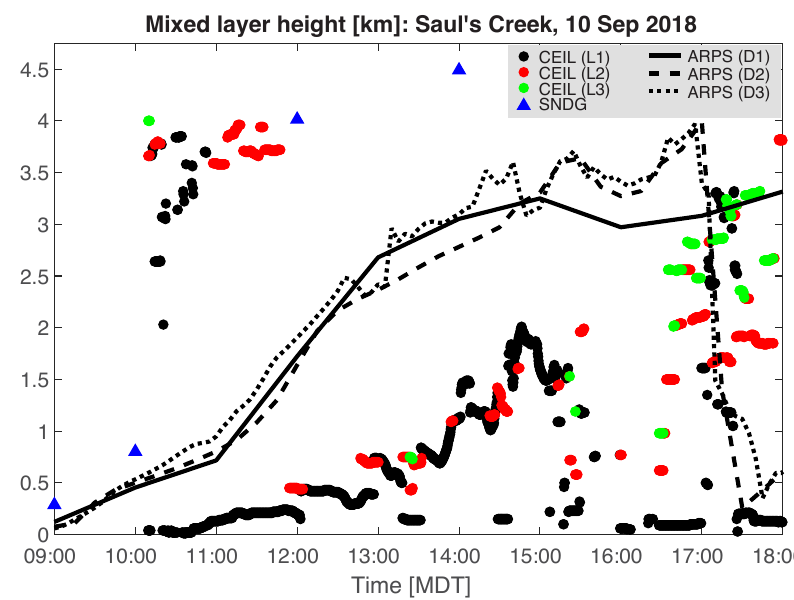
Figure 4. Time series comparison of observed mixed layer height from ceilometer aerosol backscatter returns (CEIL (three aerosol layers): black, red, and green circles) and portable rawinsonde soundings (SNDG: blue triangles), and model estimated mixed layer height from soundings extracted at nearest grid point to center of two burn units depicted in Figure 1c (ARPS (domains D1-D3): lines). Sounding-based mixed layer height is defined in this study as the height above the surface where virtual potential temperature first exceeds the lowest-level value, plus a 1-K perturbation; see text for details. See Section 2.1 for details on the relationship of ceilometer aerosol layers and mixed layer height